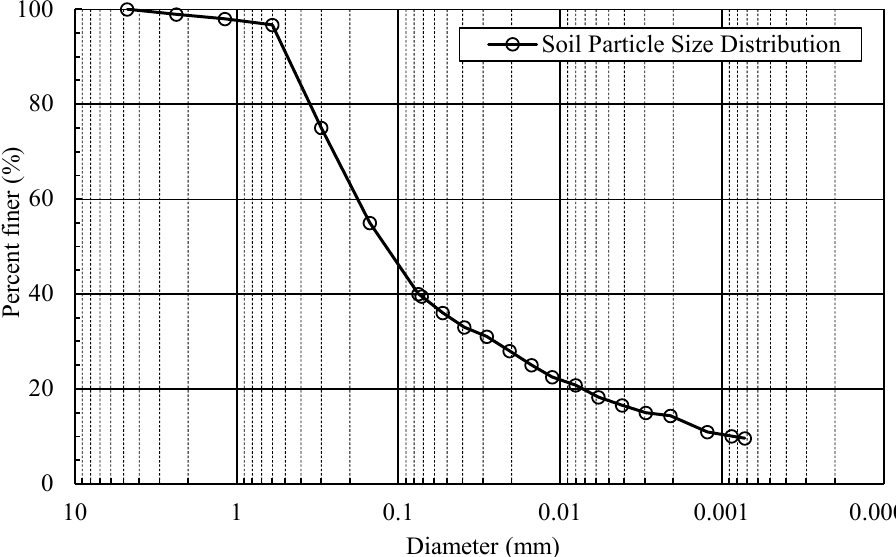
Figure 2. Grain size distribution of the soil used in the study.